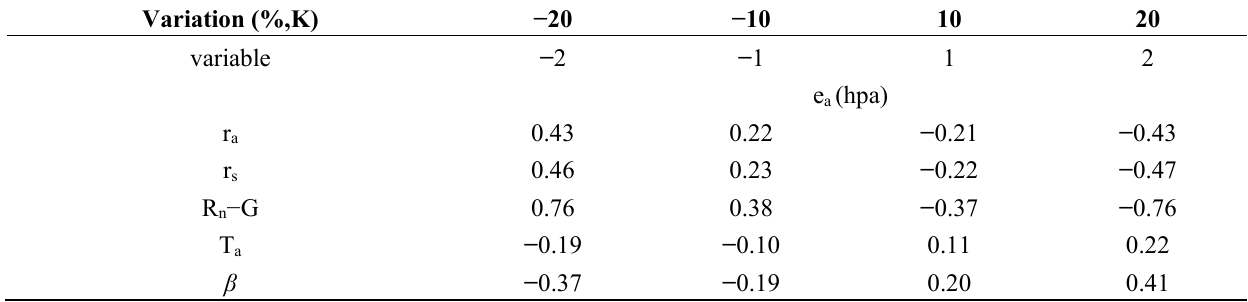
Table 5. The sensitivity of e a estimates from the ADEBAV method to each input variable. Variations of T a are in K, and variations of other variables are a percentage (%). Variation (%,K) −